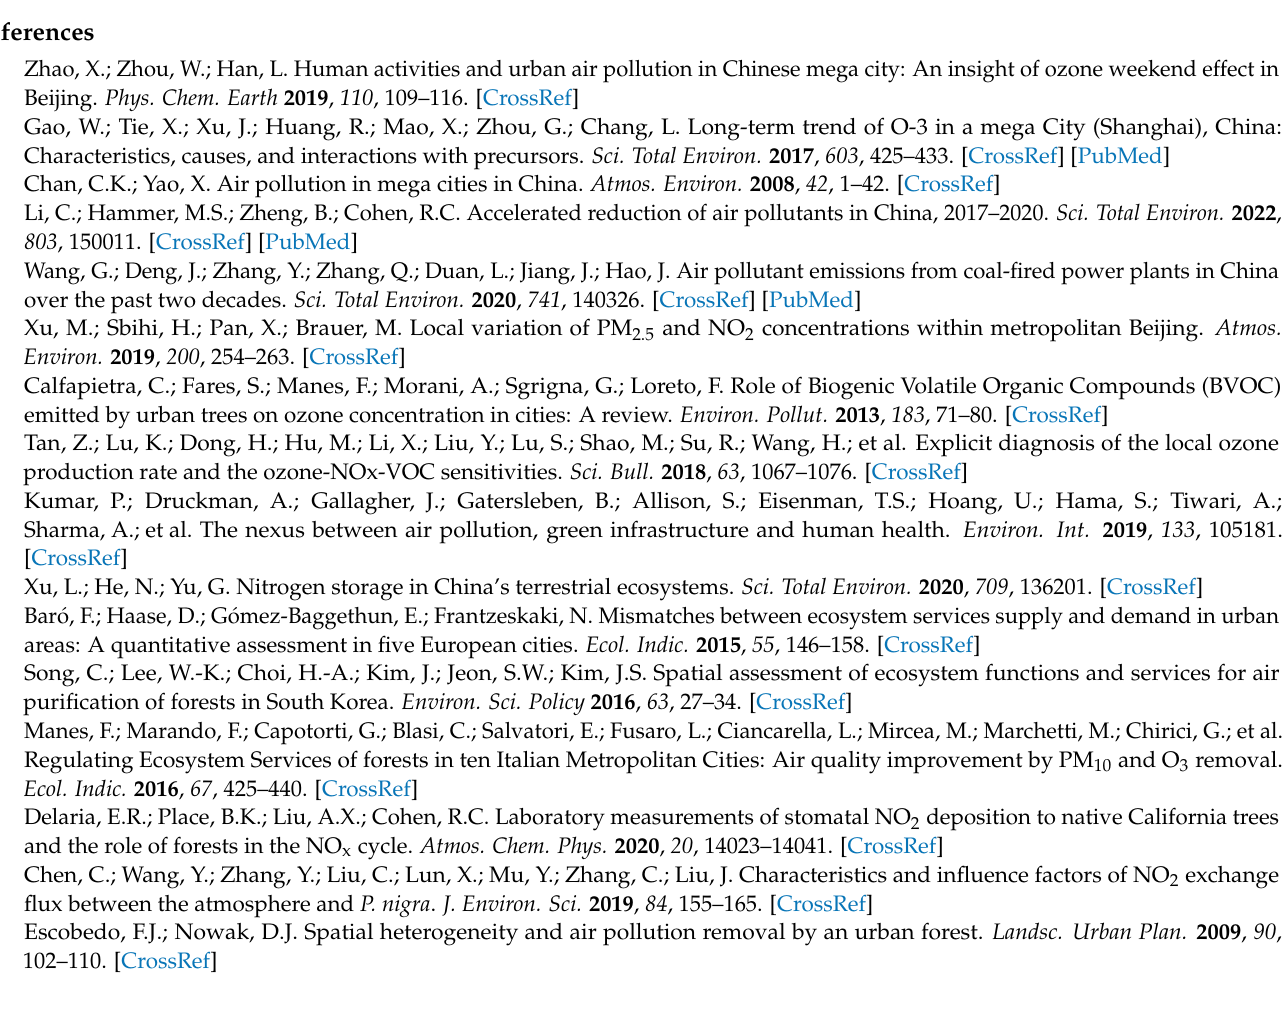
Table S4: model selection using a backward procedure based on AICc, VIF, and adjusted r square of the best set of explanatory factors explaining the variation of NO 2 removal capacity; Table S5: model averaging of the final best models within a ∆ AICc < 5 for NO 2 removal capacity; Table S6: the scores of explanatory factors on the principal